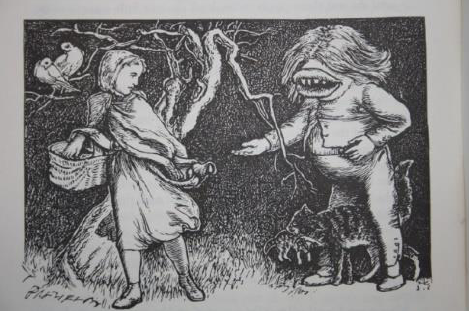
Figure 2. “The boy with the great mouth full of teeth grins at Maggie” (Hughes 1998).